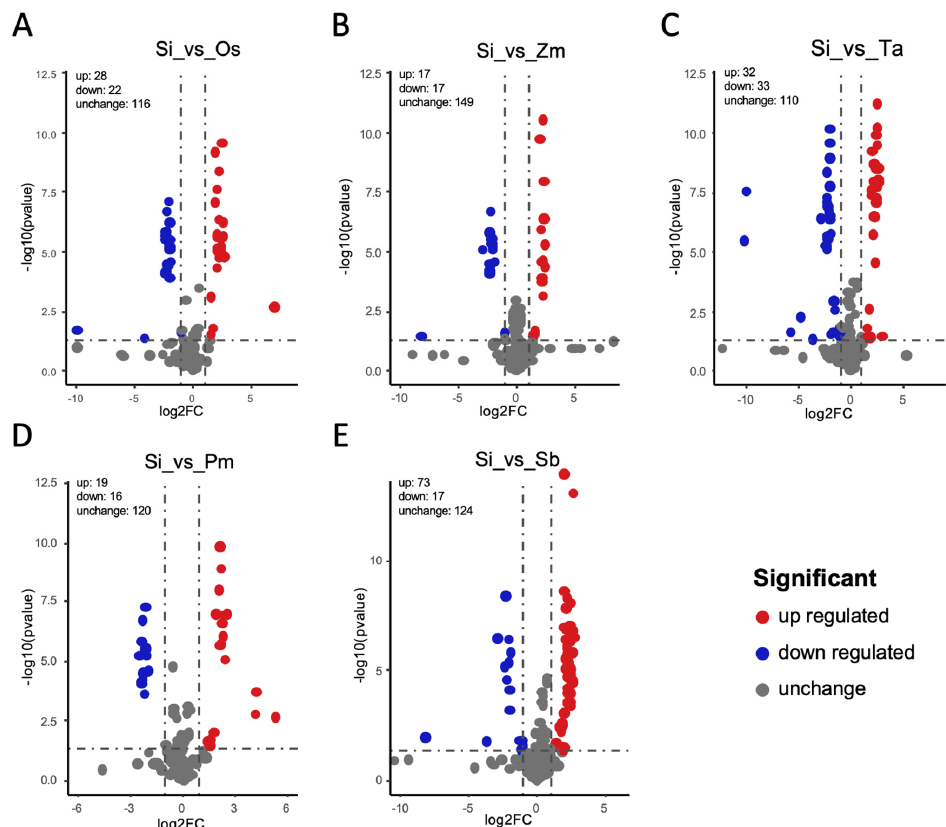
Figure 4. Identification of differential metabolites for five comparison groups ( A ) Si vs. Os, ( B ) Si vs. Zm, ( C ) Si vs. Ta, ( D ) Si vs. Pm, ( E ) Si vs. Sb. Differential metabolites plotted as a volcano. A metabolite is represented by each point on the graph. Up-regulated metabolites are represented by red dots, down-regulated metabolites are represented by blue dots, and metabolites with insignificant differences are represented by black dots.